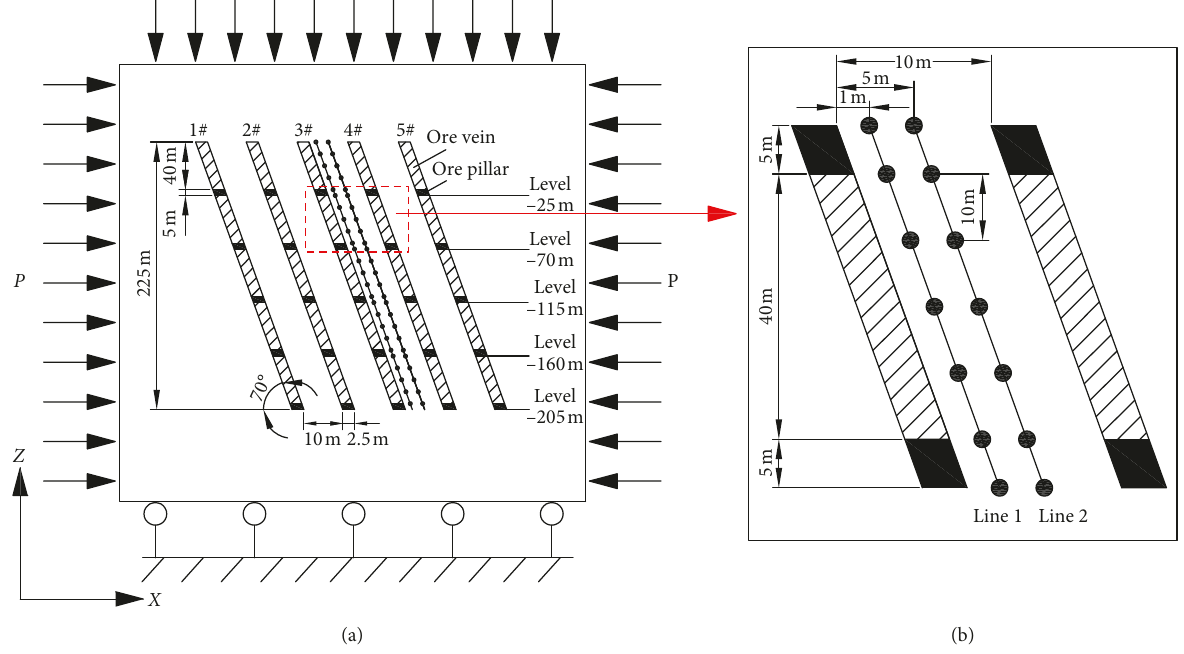
Figure 12: (a) Numerical calculation model and (b) monitoring points